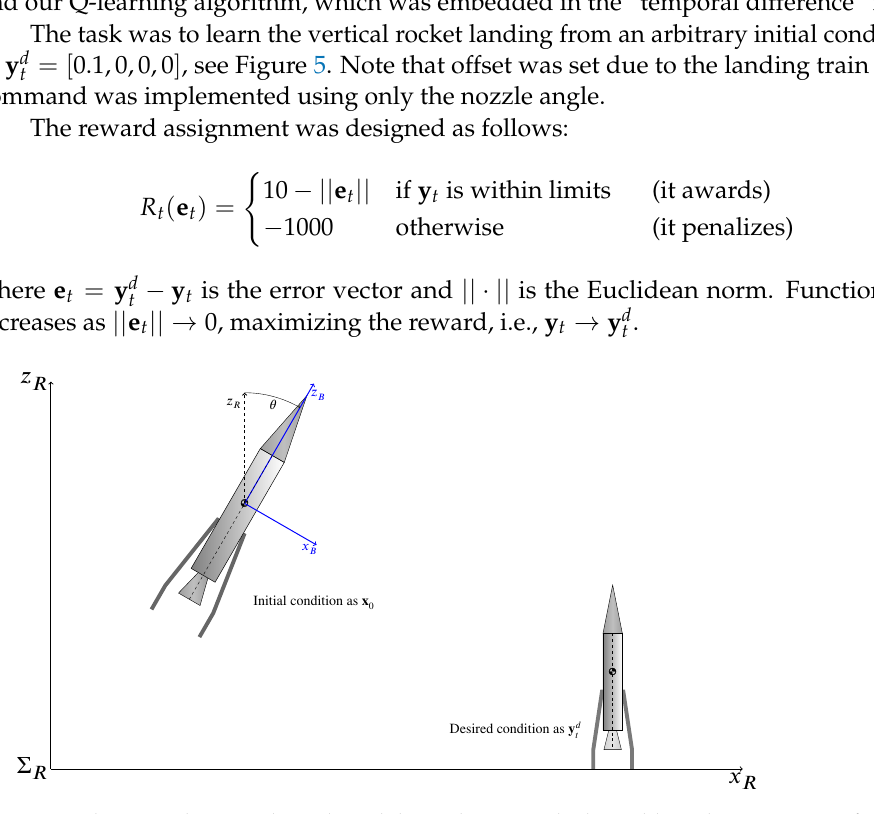
Figure 5. Schematic showing the task goal: learn the optimal admissible rocket trajectories for landing from an arbitrary initial condition x 0 to a (constant) desired landing spot y t